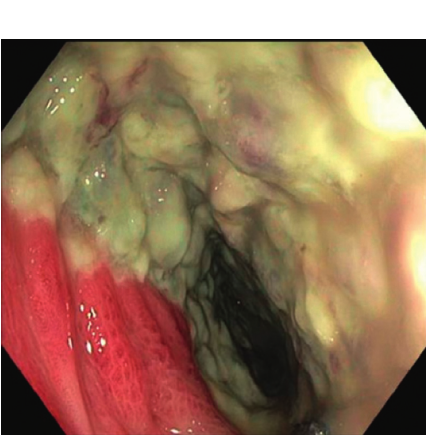
Figure 2: Distal sigmoid colon showing severe